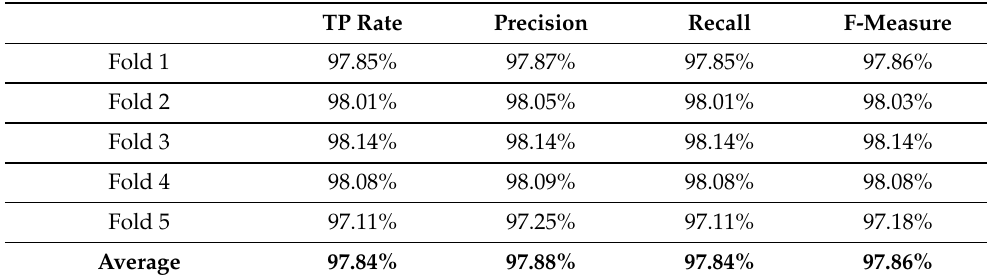
Table 6. The classification TP rate, precision, recall and F1-score of the high-resolution frames during cross-validation.